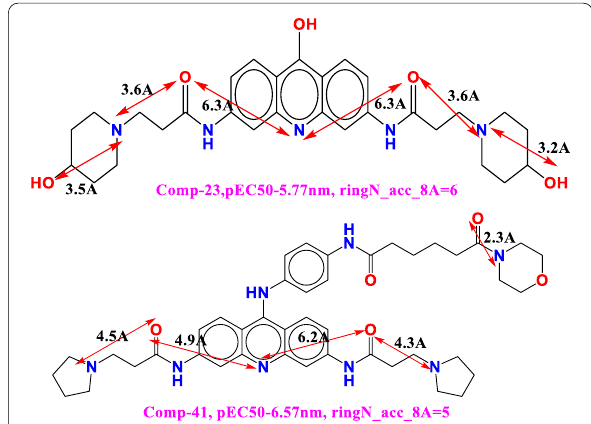
Fig. 8 Depiction of descriptor ringN_acc_8A occurrence of ring nitrogen within 8 A from acceptor atom (acceptor atom indicated in red bold words and ring nitrogen indicated in blue bold